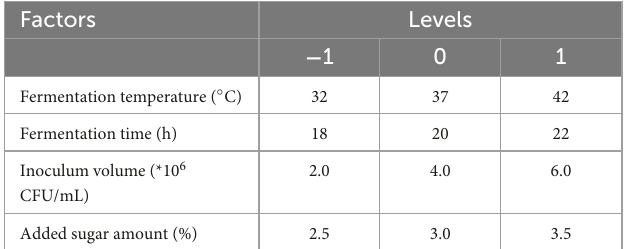
TABLE 2 Factors and levels of the